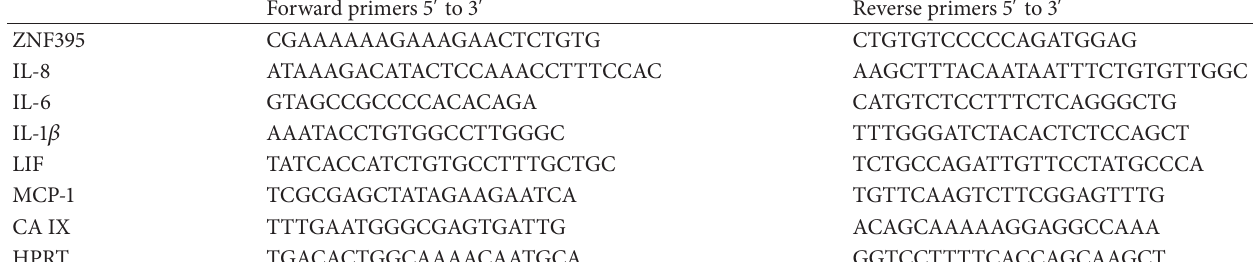
Table 1: Primers used for quantitative real time-PCR.